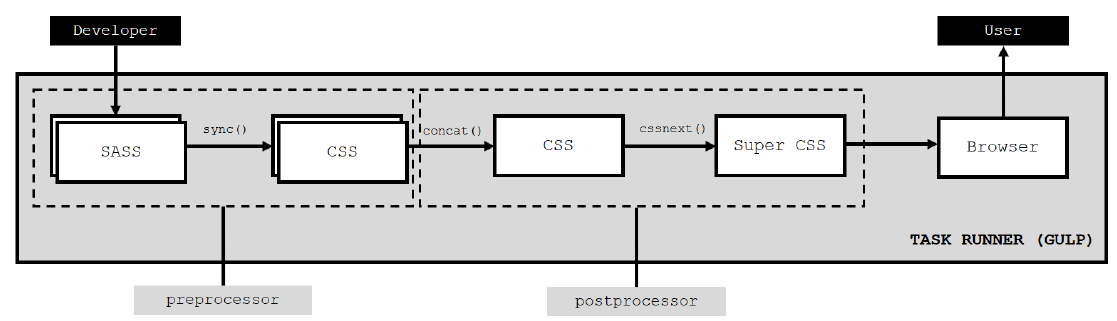
Figure 4. The CSS workflow with the two CSS processor